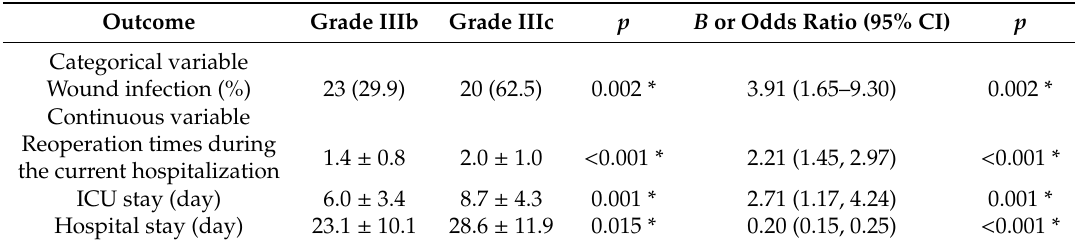
Table 3. Outcome comparison between grade IIIc and grade IIIb.